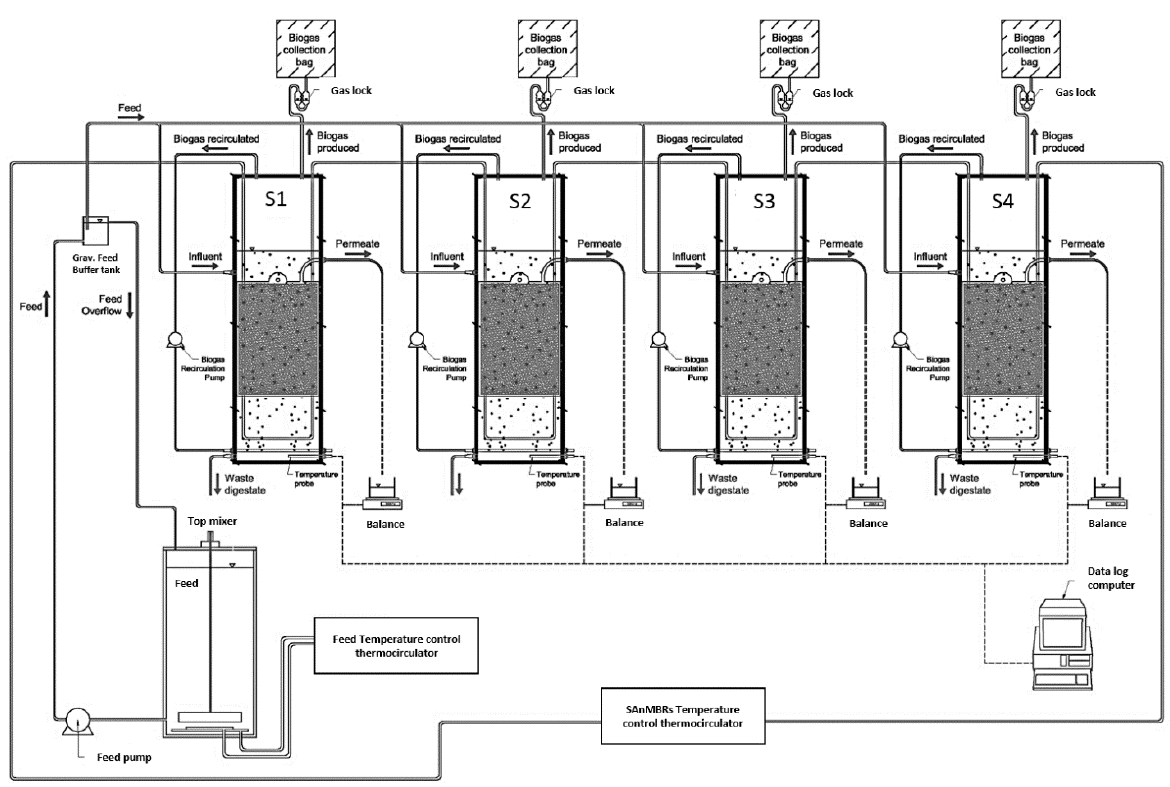
Figure 1. Schematic of experimental set-up for SAnMBRs.